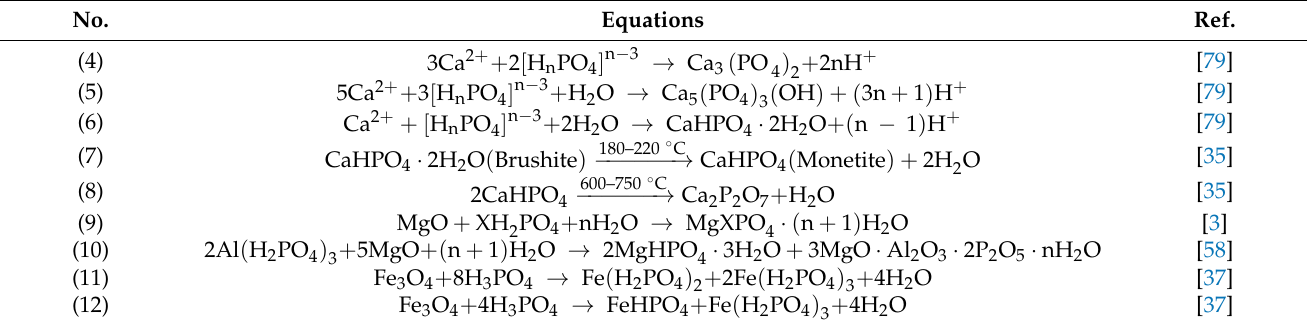
Figure 9. ( a ) XRD patterns of the HCFA-ASP geopolymers and ( b ) SEM/BSE images and elemental mapping results of the H30 geopolymer [35]. Table 5. Modification principle of calcium, magnesium, and iron in ASP geopolymers.